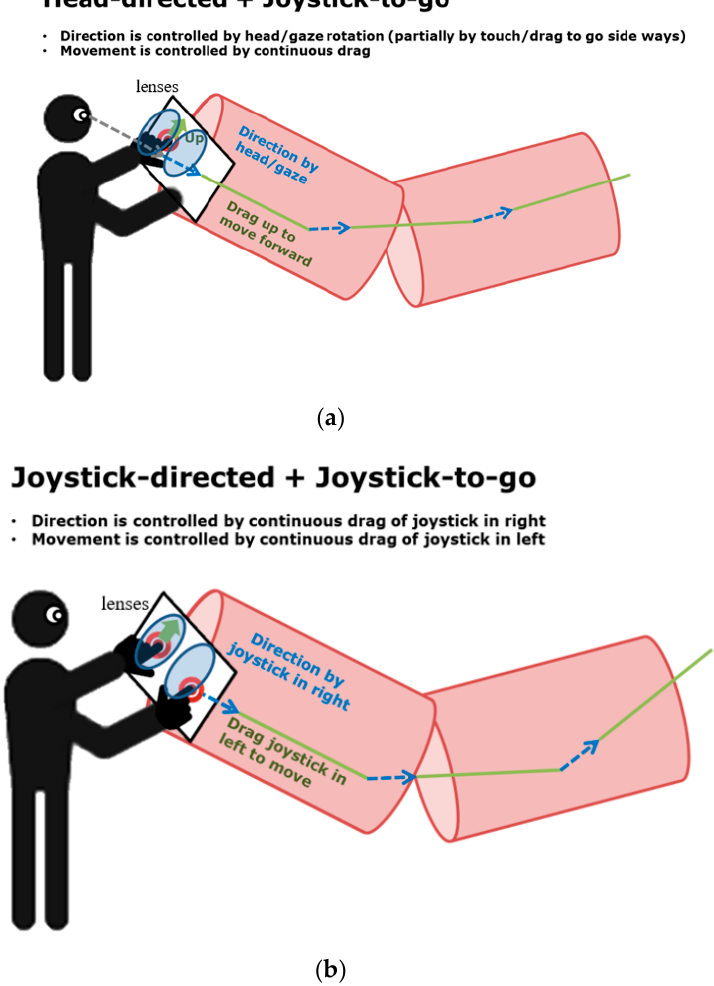
Figure 4. Head-directed + joystick-to-go (HD + JG) ( a ) and joystick-directed + joystick-to-go (JD + JG) ( b ). The red cylinders represent the virtual tunnel segments through which the user needs to navigate in the experimental task. The virtual joystick on the left controls the movement by drag. As for direction control, HD + JG relies on the user’s head orientation (estimated by the phone direction) and JD + JG by another joystick on the